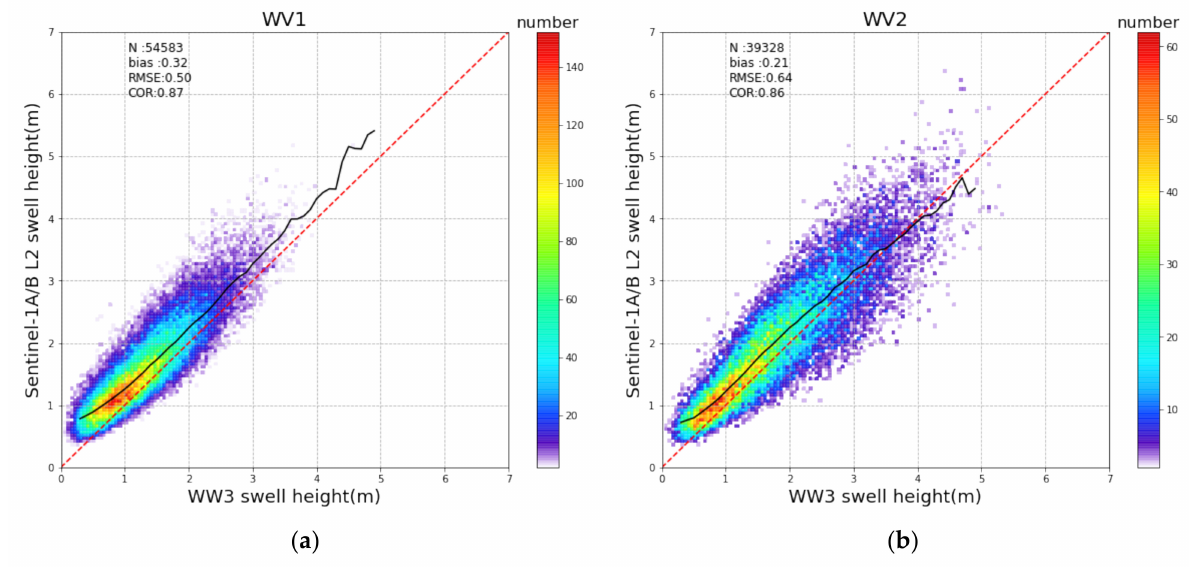
Figure 12. As in Figure 11, but for match-ups of WW3-2. ( a ) The results with the S-1A/B data in WV1 and ( b ) WV2.